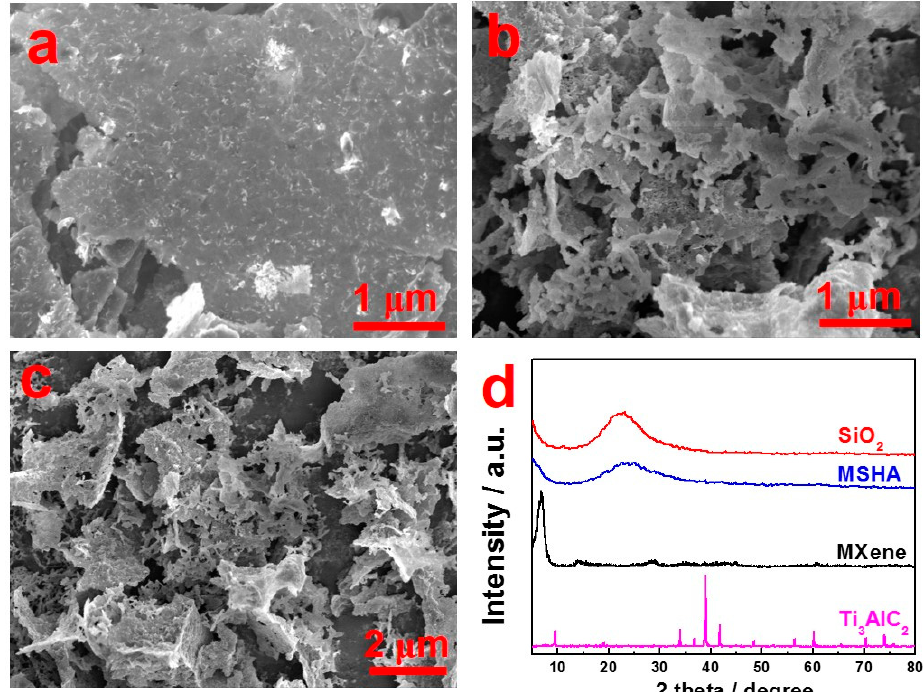
Figure 2. SEM images of the etched Ti 3 C 2 T x sample ( a ) and porous MSHA ( b , c ); ( d ) XRD patterns of Ti 3 AlC 2 , SiO 2 , MSHA, and Ti 3 C 2 Tx.